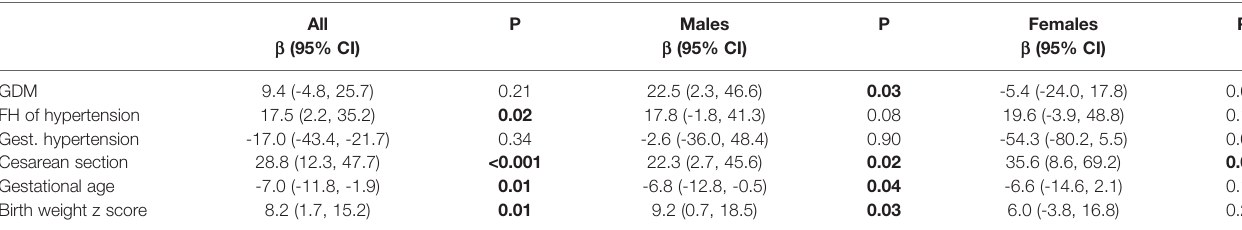
TABLE 6 | Determinants of cord plasma FABP4 concentrations. All